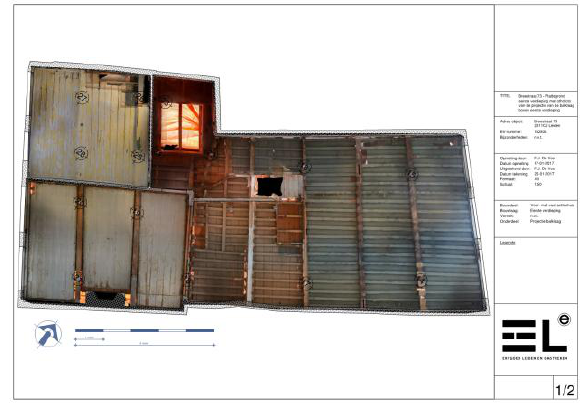
Figure 9. Orthophoto of floor construction, inserted in CAD. Plan generated using a Total Station connected to a tablet with BricsCAD. (Breestraat 73, Leiden)